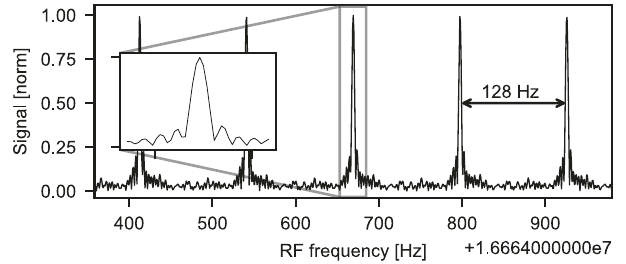
Fig. 6 Comb line structure of the optical spectrum. The inset shows a single comb line with FWHM of 3.1 Hz in radio frequency domain.